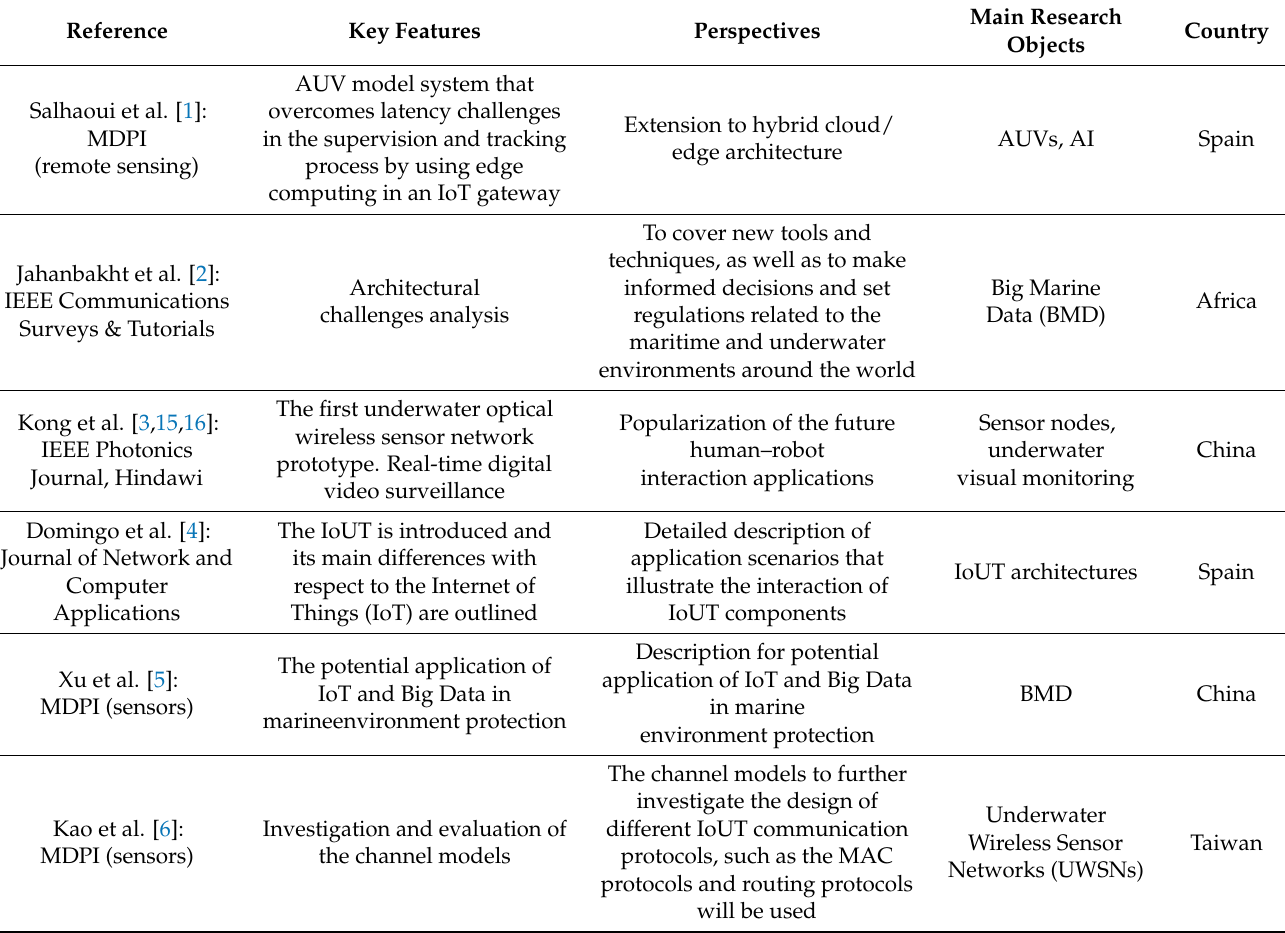
Table 1. Summary of existing MIoT